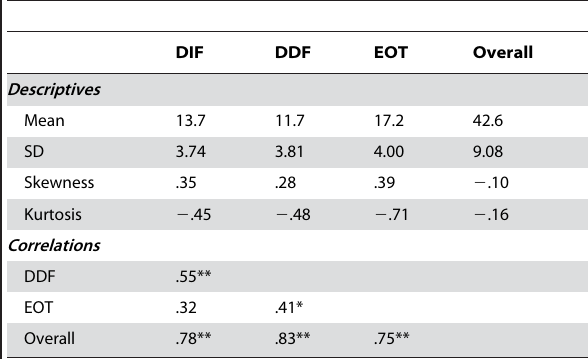
Table 1. Means, SDs, distribution, and correlations of TAS-20